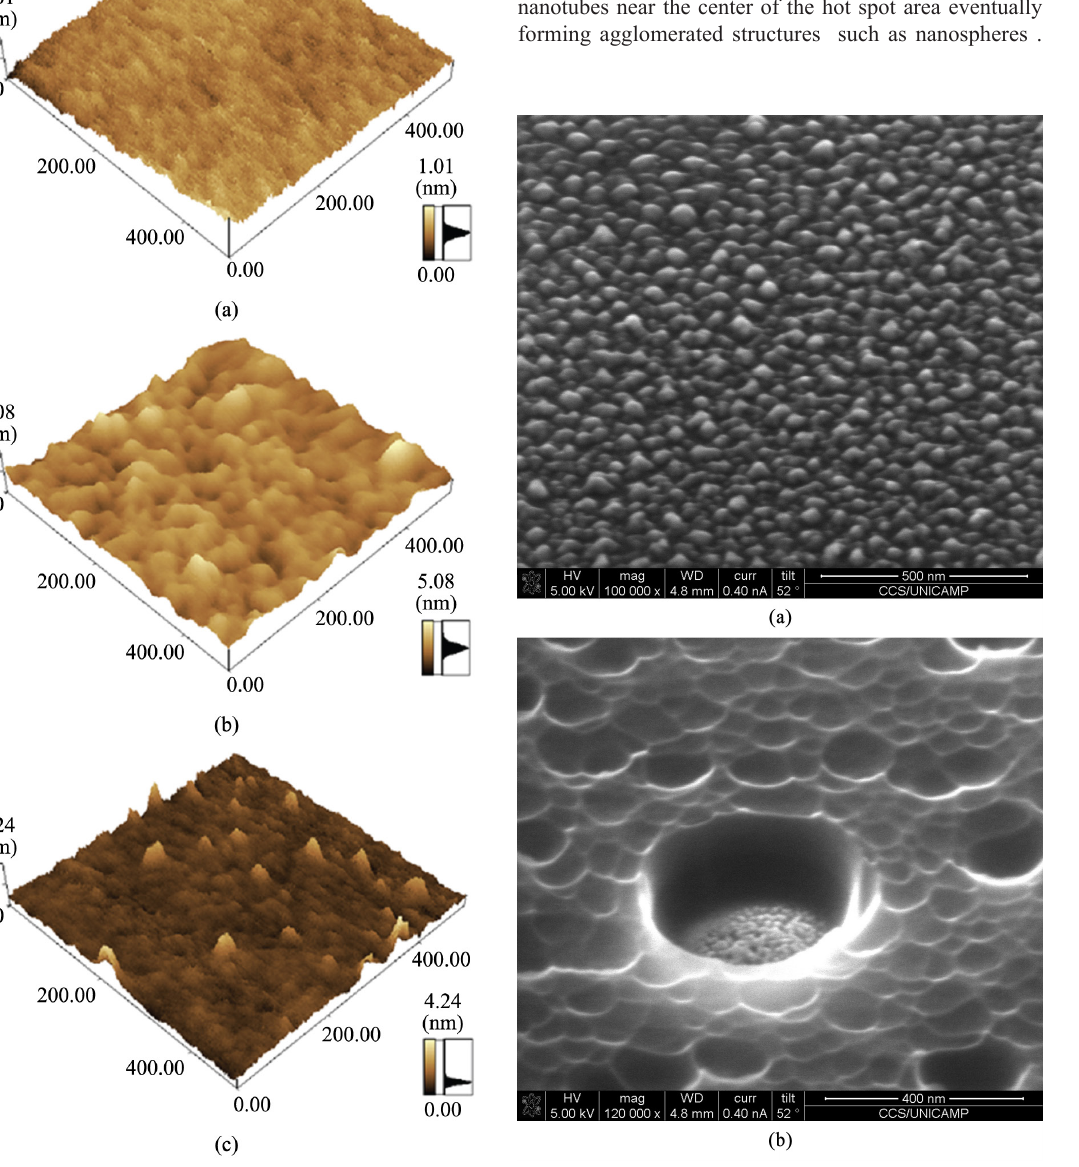
Figure 2. AFM images of the Si substrate (a) and Ni (b) and Cu (c) 3 nm catalytic films.